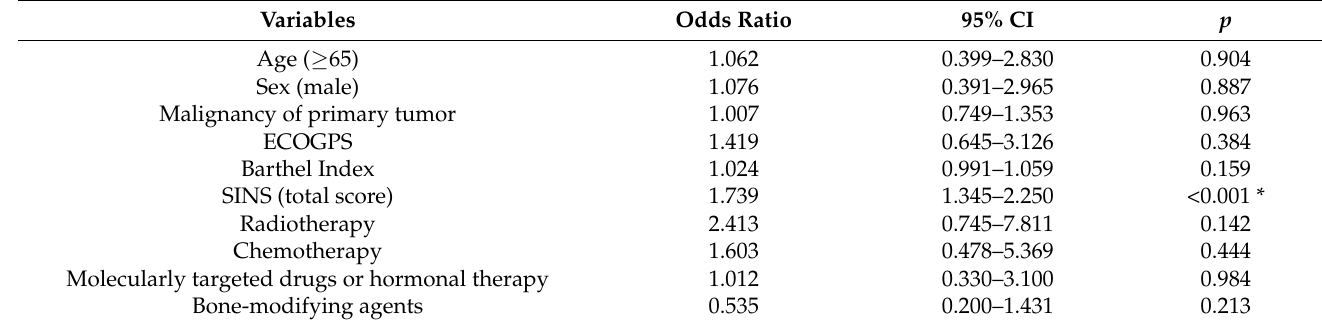
Table 3. Multivariate analysis of risk factors for symptomatic spinal metastases.